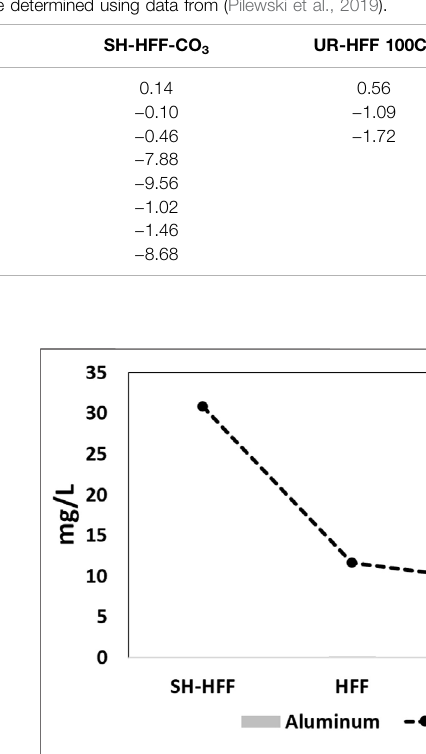
FIGURE 6 | Aluminum in solution plotted against pH to highlight the role of pH in aluminum dissolution from clay